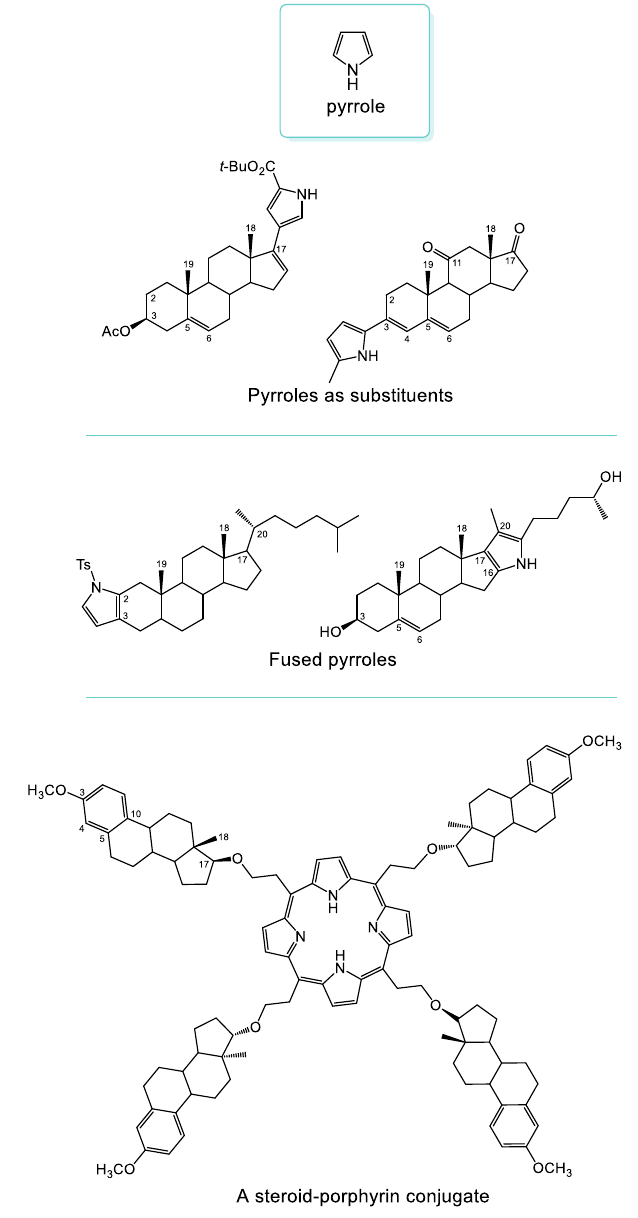
Figure 1. Pyrrole rings attached to steroidal frameworks at different positions.